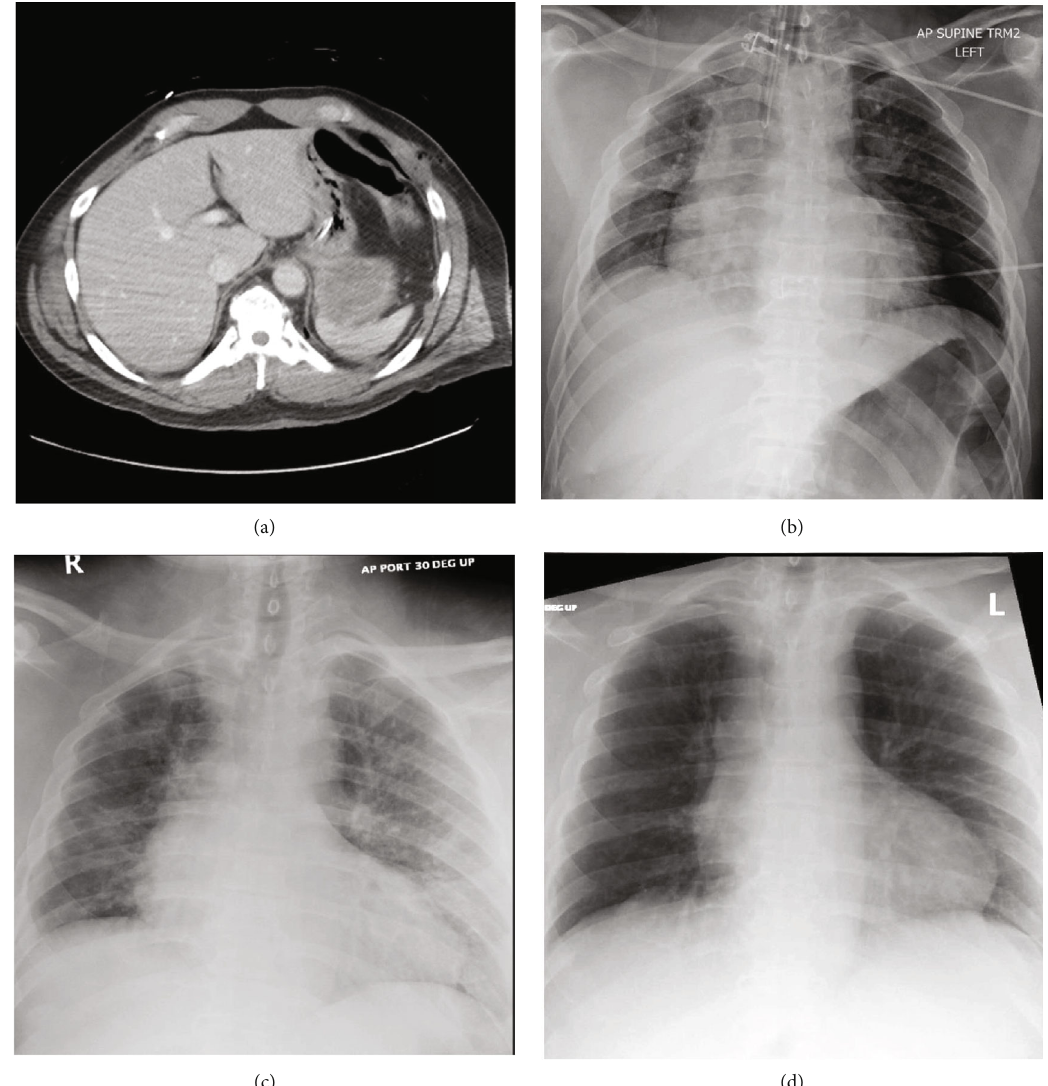
Figure 2: Patient 2 imaging including (a) admission abdominal CT with air pattern concerning for diaphragmatic injury, (b) admission chest X-ray, (c) chest X-ray after positive COVID test, and (d) chest X-ray from the time of